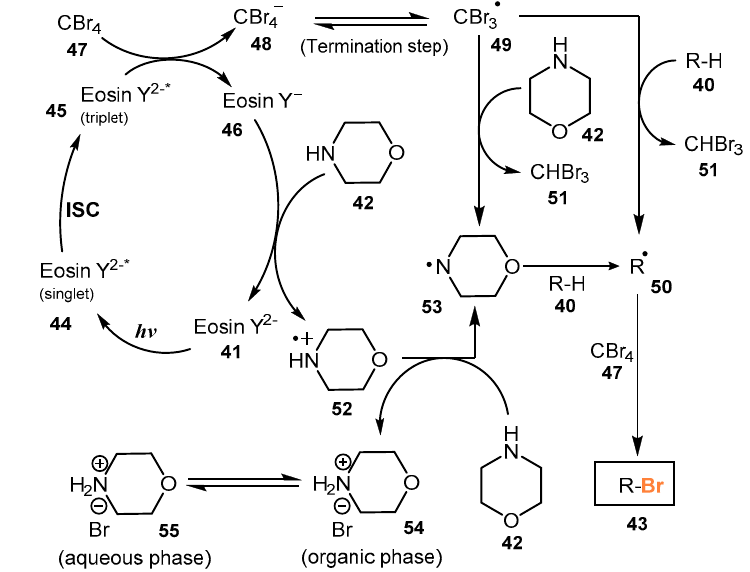
Scheme 13. Mechanism for bromination of sp 3 C-H bond promoted by Eosin Y and morpholine.